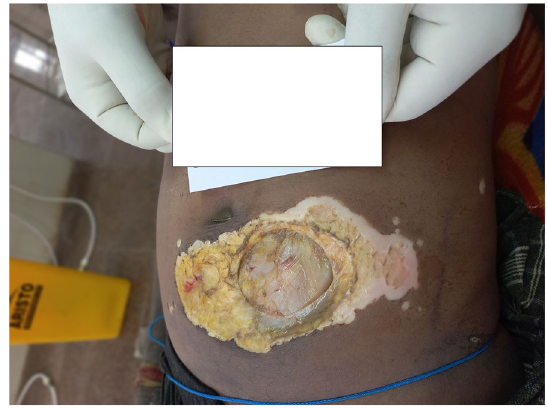
Fig. 1 Aquatic predator activity (freshwater fish)—loss of skin and soft tissue of the whole face